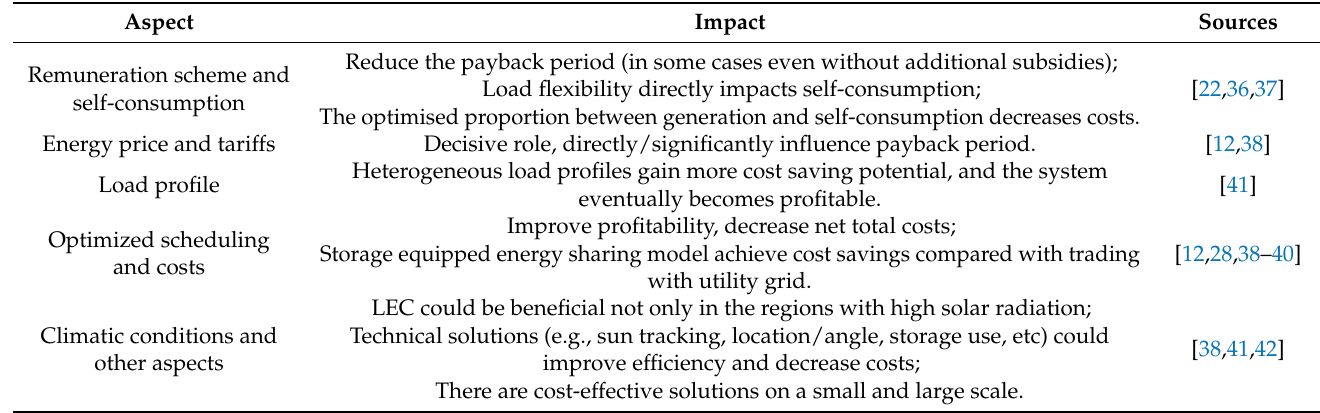
Table 1. Aspects influencing economic benefits and payback time of